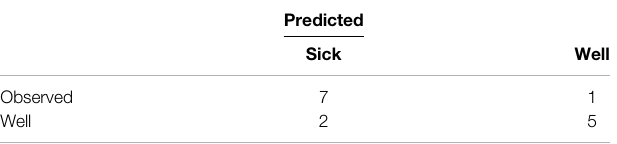
TABLE 3 | Confusion matrix between predicted and observed group in the test set.